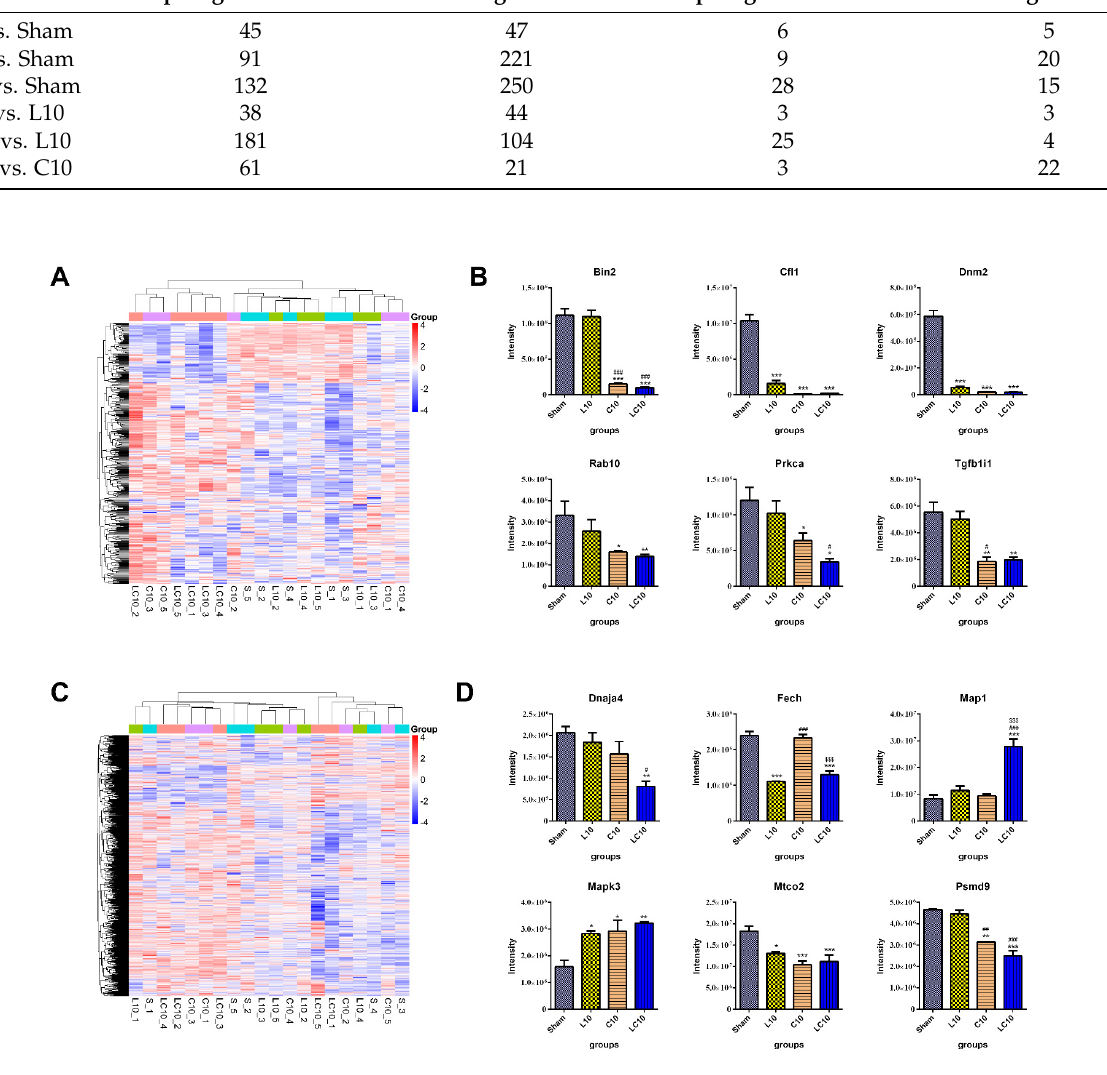
Figure 5. Proteomic analysis of differentially expressed proteins (DEPs) in peripheral blood and the spleen at 7 d after compound exposure. At 7 d after microwave exposure, the peripheral blood and the spleen were collected from the Sham group, L10 group, C10 group and LC10 group, as described in Section 4. The proteins were caught by proteominer beads from the sera of peripheral blood and spleen lysates, respectively. After enzymatic degradation and desalination, a spectral library was constructed by using a high pH reversed − phase fractionator in data − dependent acquisition (DDA) mode. Then, the samples were measured by data independent acquisition (DIA). The DEPs in peripheral blood ( A ) and the spleen ( C ) were presented, respectively. Six DEPs, both in peripheral blood (including Bin2, Cfl1, Dnm2, Rab10, Prkca and Tgfb1i1) ( B ) and in the spleen (including Dnaja4, Fech, Map1, Mapk3, Mtco2 and Psmd9) ( D ), were selected for verification by parallel reaction monitoring (PRM). Data were shown as mean ± s.e.m. *, p < 0.05, **, p < 0.01, ***, p < 0.001 vs. Sham group; #, p < 0.05, ##, p < 0.01, ###, p < 0.001 vs. L10 group; $$$, p < 0.001 vs. C10 group.